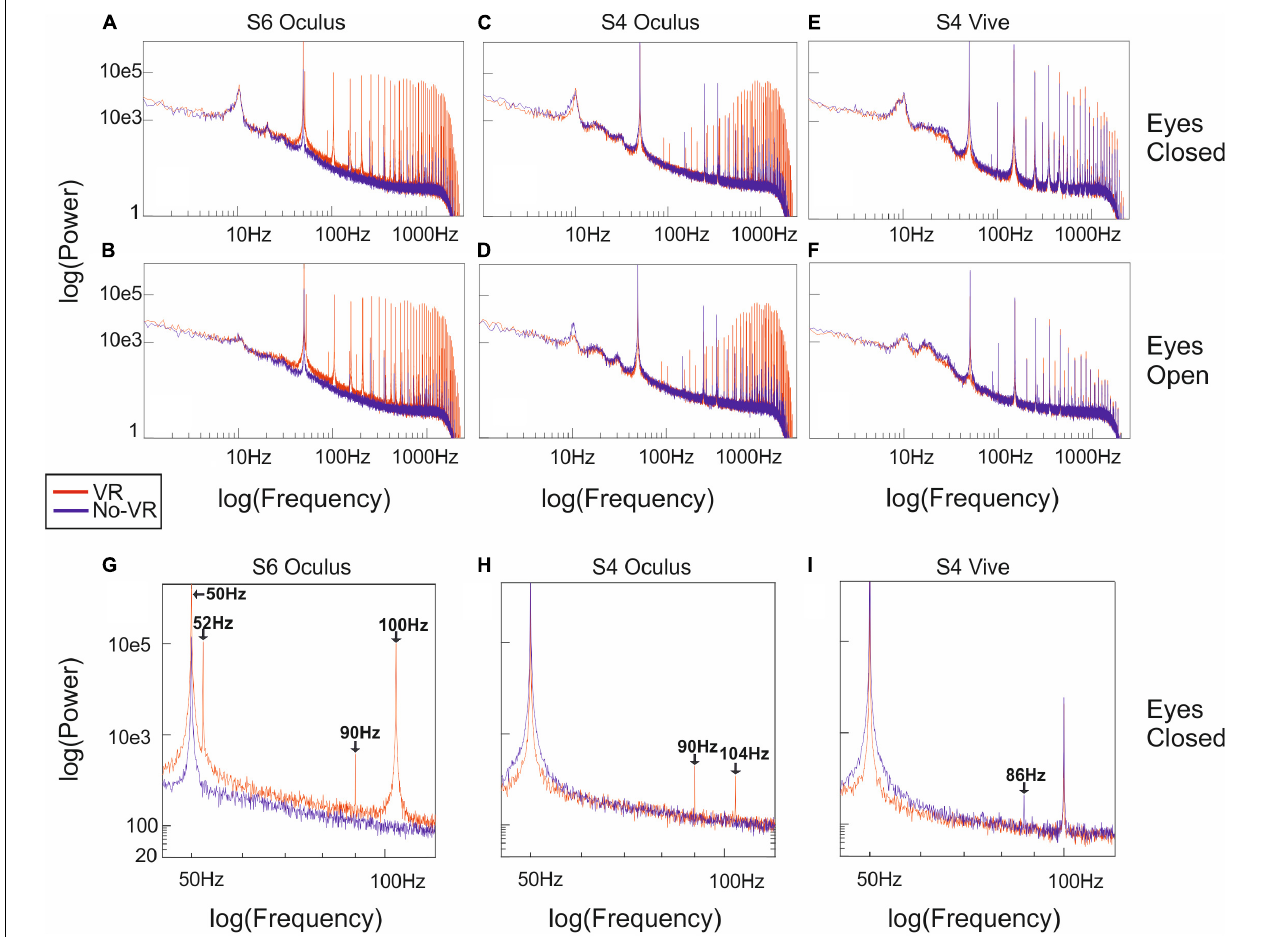
FIGURE 4 | Detailed spectral power distribution for electrode Cz: Subfigures (A–I) display examples for the spectral power over frequency at electrode Cz (the centermost electrode) for different measurements. The first row (A,C,E) show across-trial median data during the eyes-closed task, the second row (B,D,F) during the eyes-open task, in the frequency range (1, 2,500 Hz). The bottom row (G–I) displays eyes-closed data in the frequency range (45, 120 Hz) for subject 6 and 4 both using a Oculus Rift HMD and subject 4 using the HTC Vive Pro HMD. The most pronounced amplitude peaks consistently occurred around 50 Hz. Expectedly, we found high amplitudes in all eyes-closed measurements around 10 Hz, compared to their eyes-open equivalent (e.g., A,B ). Additional peaks occurred at 52 and 90 Hz in the VR condition when subjects were wearing a HMD (i.e., G,H ), while subject 4 using the Vive Pro showed an additional peak at 86 Hz for No-VR conditions. Colors represent measurement conditions for VR (red) and No-VR (blue). For all subfigures the x -and y -axis, respectively, denote frequency (Hz) and spectral power ( µ v 2 ) logarithmically. See Supplementary Figure 1 for detailed spectral power distribution of all